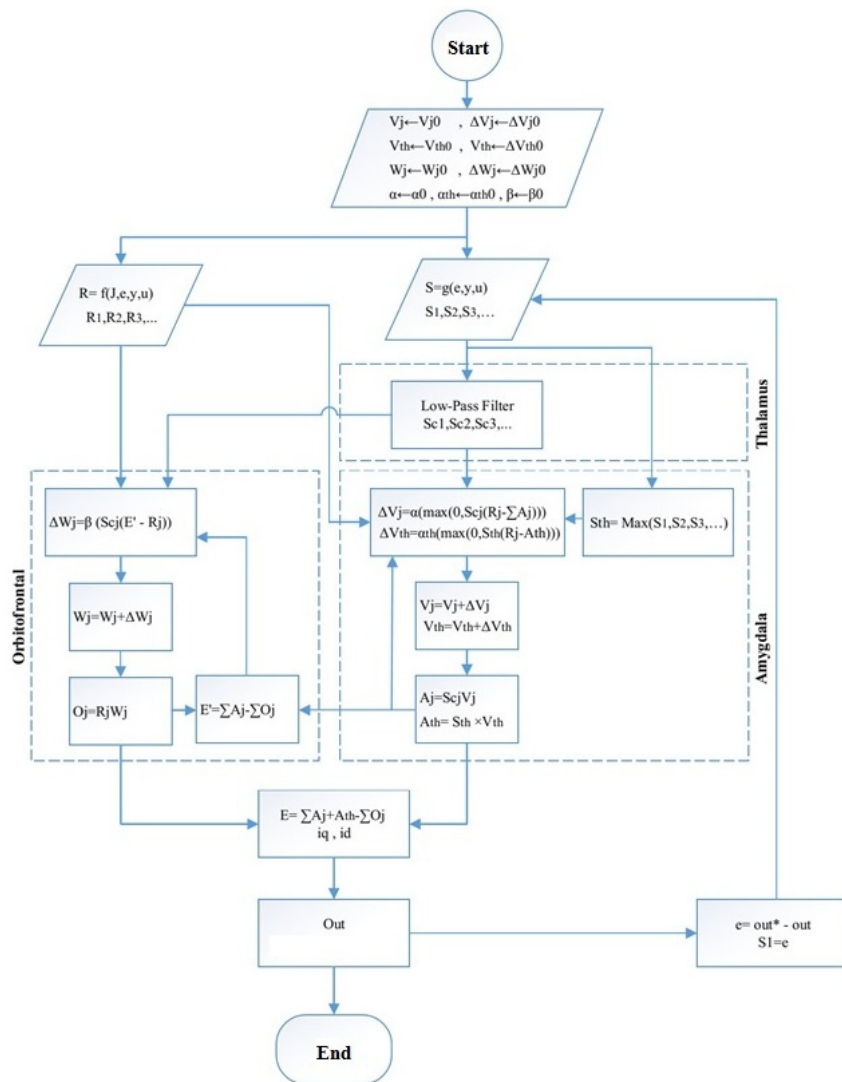
Figure 6. A graphical scheme of the single-layer emotional controller, adopted from [22].